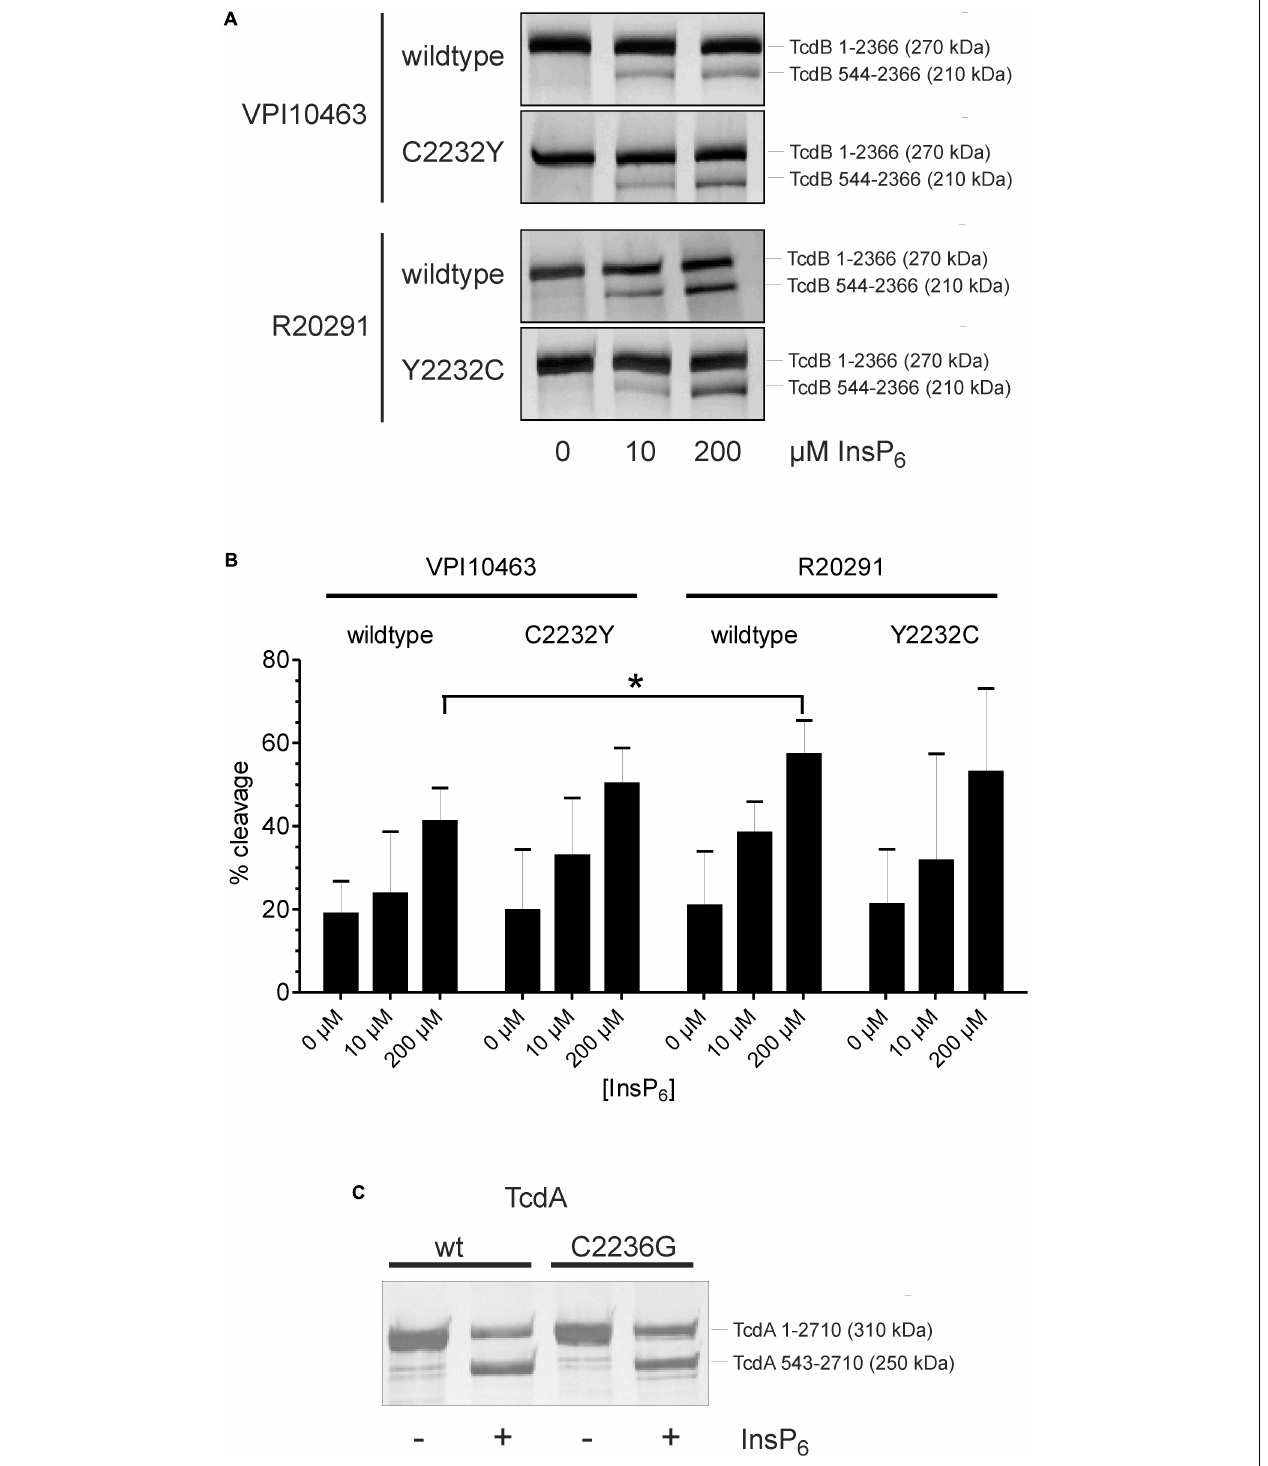
FIGURE 2 | Autoproteolysis of TcdB. (A) Autoproteolytic cleavage of TcdB from strain VPI10463 and R20291 (2 µ g each) is induced with different concentration of InsP 6 . Silver-stained gel shows full-length toxin (270 kDa) and the long cleavage product TcdB 544-2366, lacking the GTD (210 kDa). (B) Densitometrical evaluation of four separate cleavage experiments reveals no significant differences in cleavage of the mutated toxin compared with the wildtype form. Given are the percentage of cleaved product compared to full-length toxin (means ± SD, n = 4). (C) InsP6-induced cleavage of TcdA and TcdA C2236G (strain VPI10463). Silver-stained gel is representative for three independent experiments.